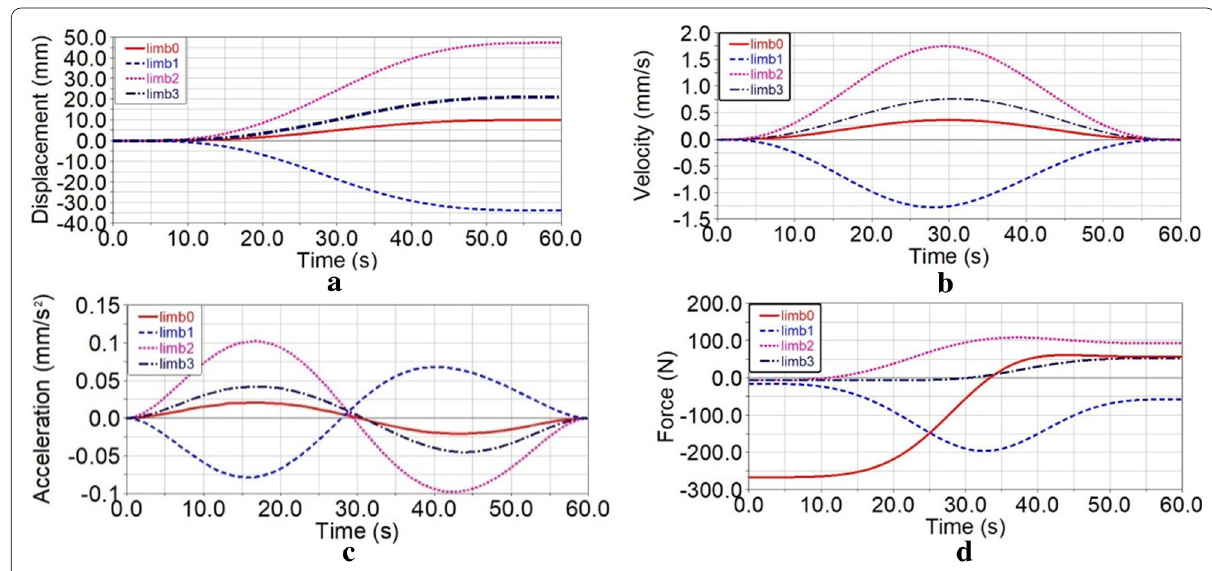
Figure 12 a Displacement, b velocity, c acceleration, and d driving force of each limb of module 5